Question: What direction does the quantity move in — increasing or decreasing?
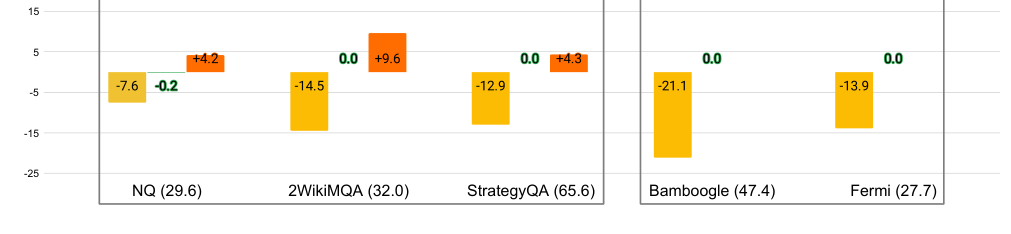
Answer: decreasing